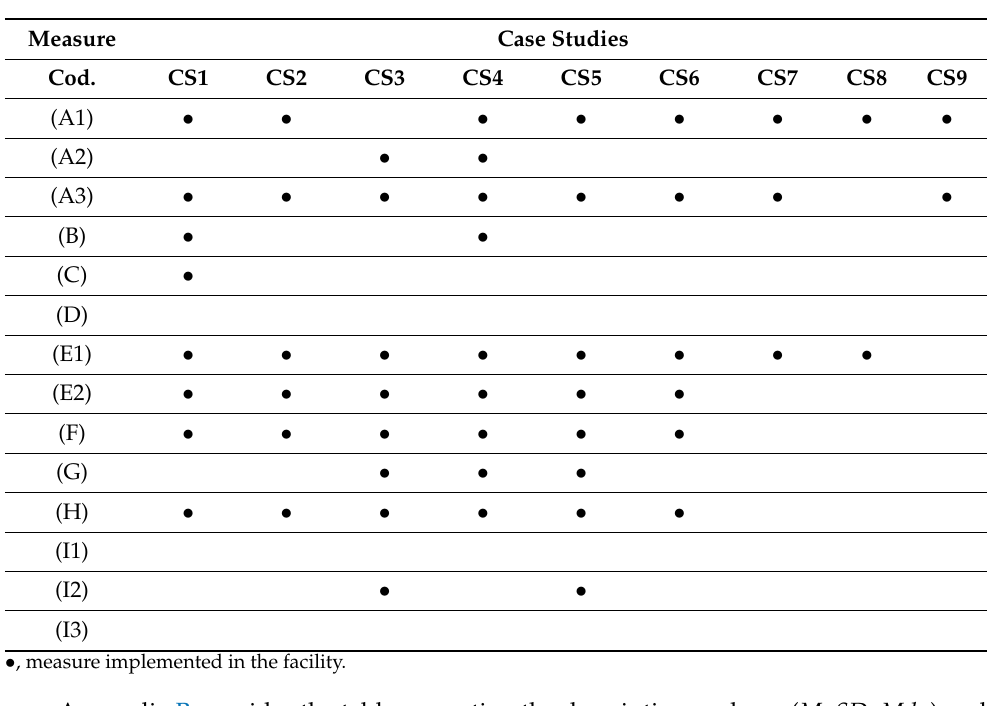
Table 10. Mitigation/prevention measures implemented in the facilities investigated in the case studies survey research. Own